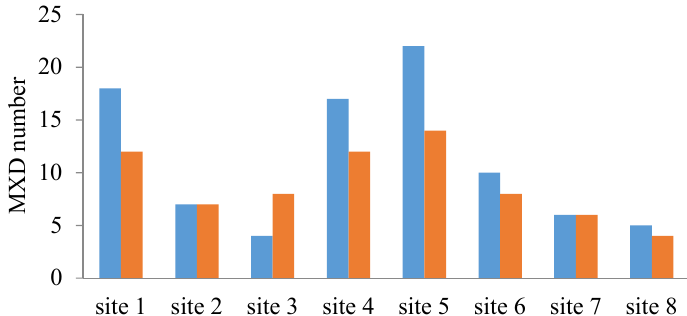
Fig. 3: Tree diagram for 160 series (UV-B responsive trees are marked with red and climatic-responsive trees are marked with blue)